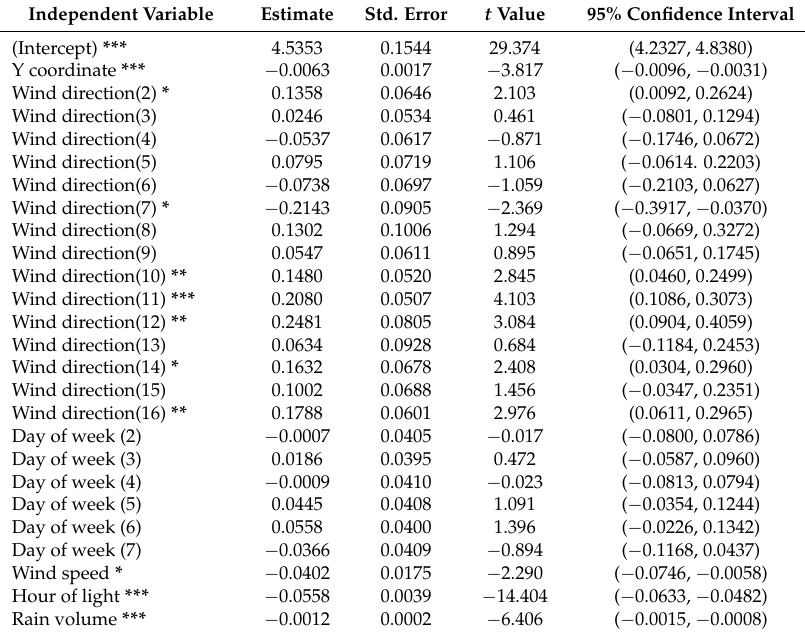
Table 5. Parametric coefficients of GAMM ( n = 3593).